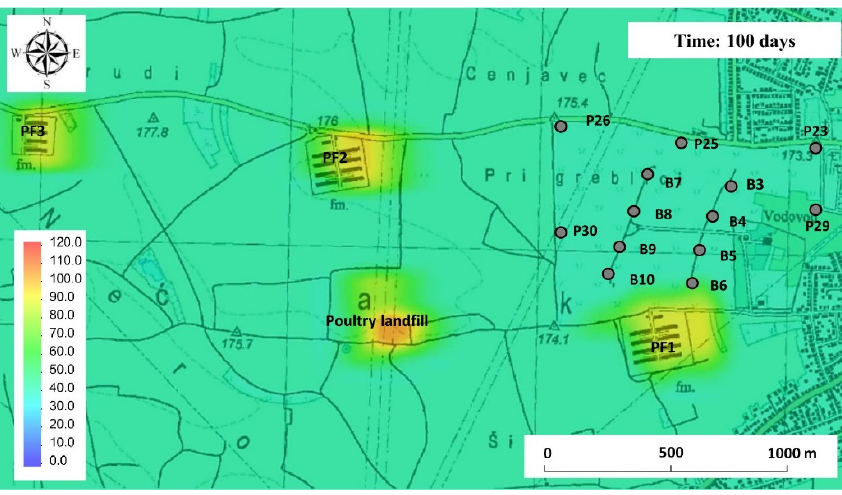
Figure 8. Nitrate pollution propagation by impulse initial conditions—100 days.